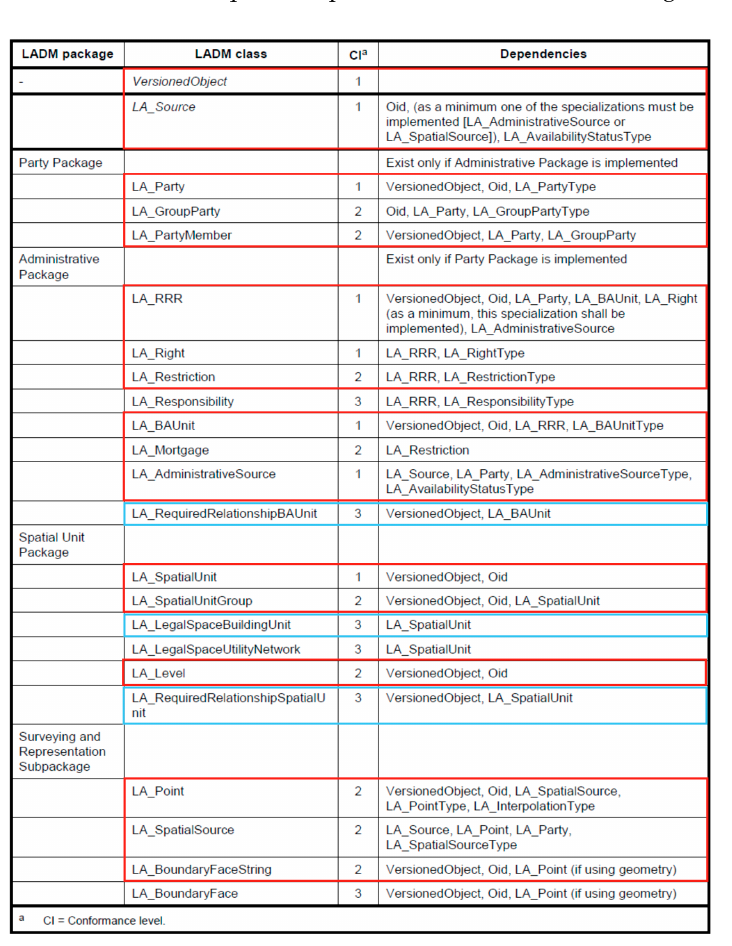
Figure 11. The LADM conformance requirements table [1]. The classes for conformance Level 2 are highlighted in red rectangles. The Czech profile also contains some Level 3 classes (highlighted in blue rectangles).